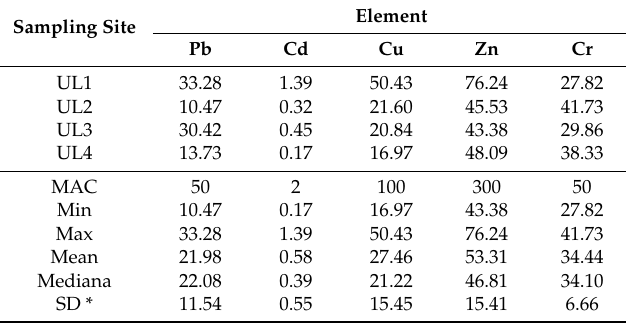
Table 8. Total contents and descriptive statistics of elements in Ulcinj (UL) urban parks soil samples for this study (mg ¨ kg ´ 1